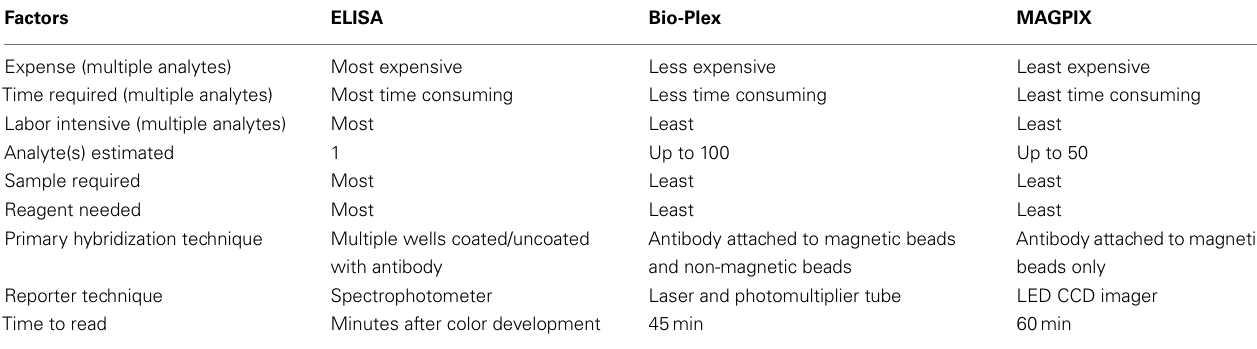
Table 1 | Comparisons of traditional ELISA with two multiplexing